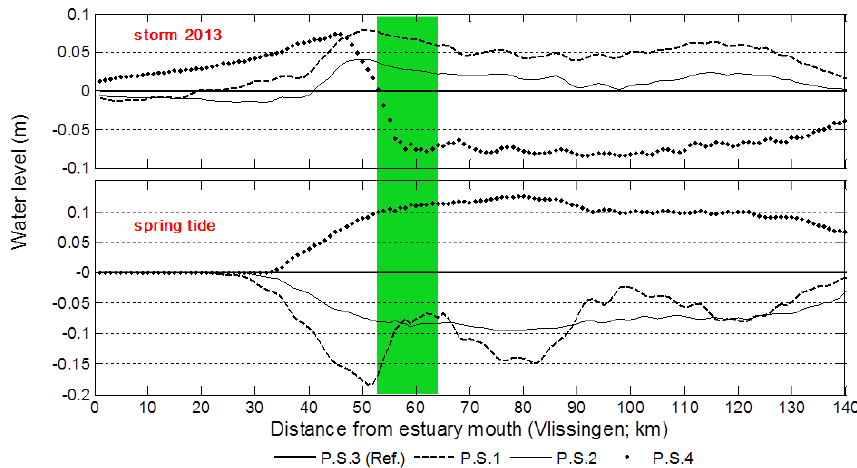
Figure 5. Scenarios with schematic wetland elevations relative to reference scenario P.S.3. Scenarios given for spring tide and storm tide (2013). The green area in the figure shows the location of the Saeftinghe wetland in the